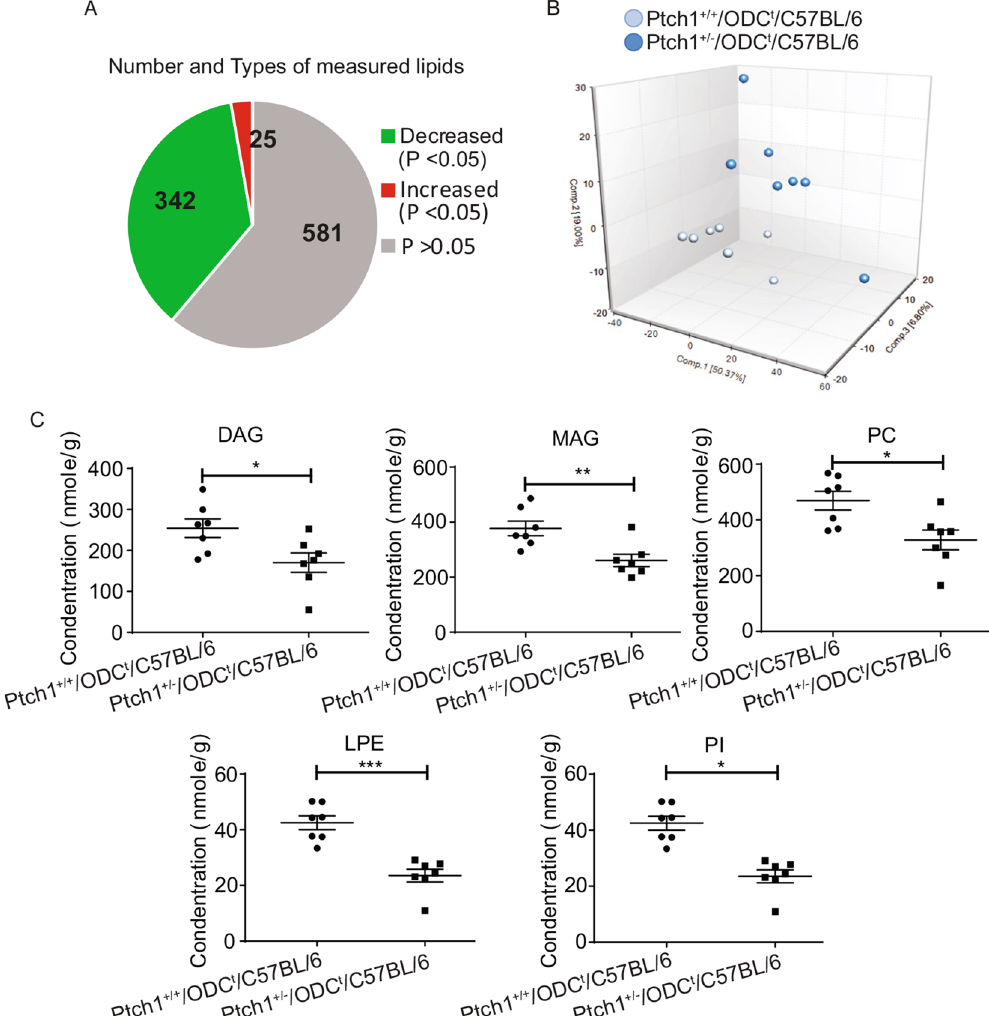
Figure 3. Effects of Ptch1 +/− heterozygosity on lipid profile in the skin. ( A ) Pie chart depicting the numbers of lipids, which are increased or decreased in the skin; ( B ) Graph showing principle component analysis of lipidomics data; ( C ) Graphs showing impact on mono & diacylglycerols, phosphatidylcholines, lysophosphatidylethanolamines, and phosphatidylinositol. *p < 0.05; **p < 0.01; ***p <